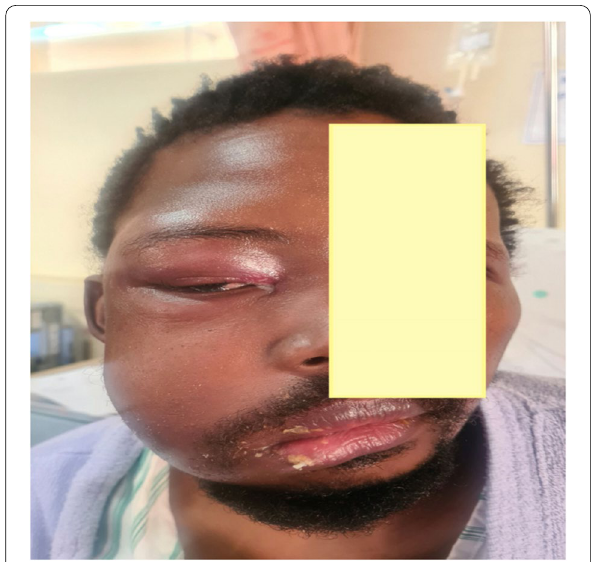
Fig. 1 Right facial swelling and cellulitis